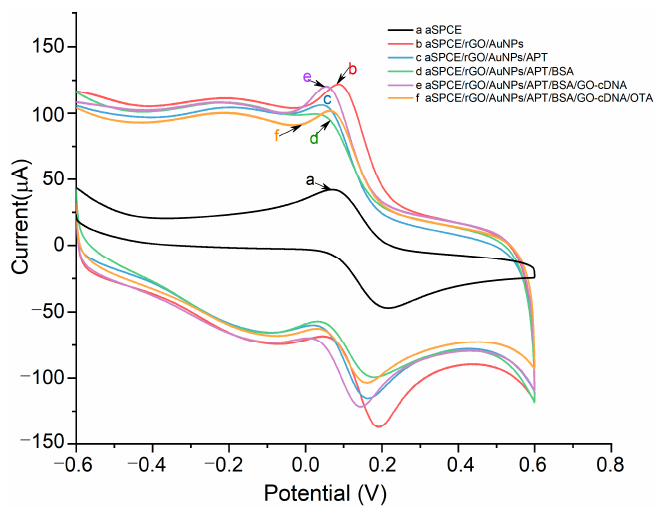
Figure 2. CV curves of the modified aSPCEs of every step (a, bare aSPCE; b, aSPCE/rGO/AuNPs; c, aSPCE/rGO/AuNPs/APT; d, aSPCE/rGO/AuNPs/APT/BSA; e, aSPCE/rGO/AuNPs/APT/BSA/GO-cDNA; f, aSPCE/rGO/AuNPs/APT/BSA/GO-cDNA/OTA) in a solution of 0.01 M PBS pH 7.4 con- taining 0.01 M [Fe (CN) 6 ] 3 − / 4 − and 0.1 M KCl.